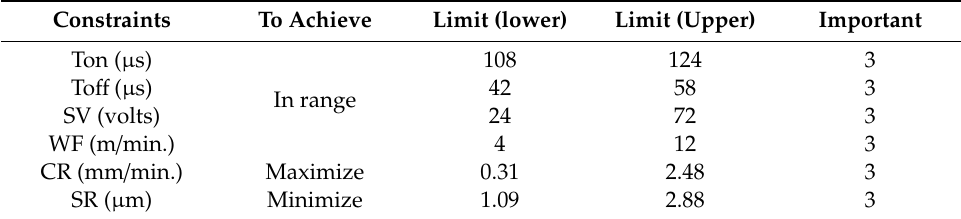
Table 7. Constraints for input and output